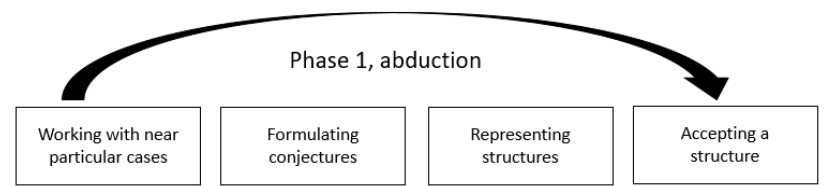
Figure 10. Abduction phase.